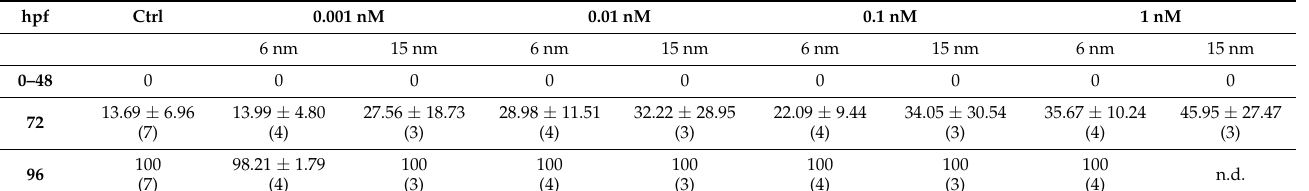
Table 2. Hatching percentage of embryos exposed to 0.001–1 nM 6 or 15 nm GNP@PMA. Mean ± SE of 3–7 experiments.